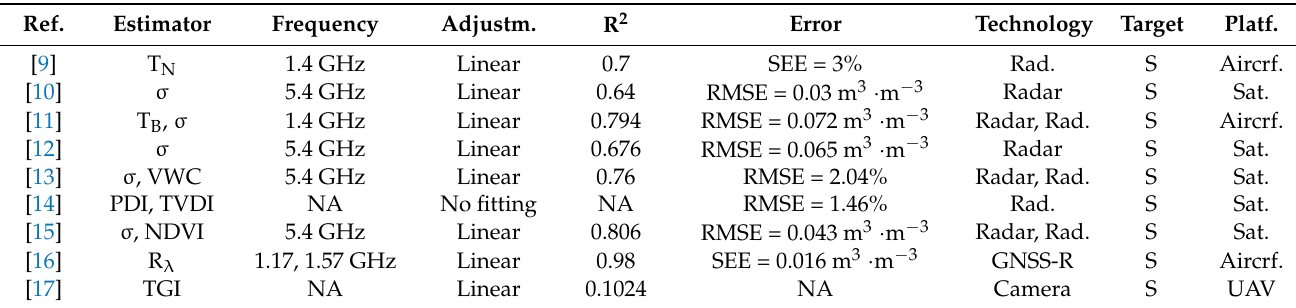
Table 2. Summary of the estimators used in soil techniques together with the operating frequency, type of adjustment, R 2 , estimation error, technology, target and sensor platform.